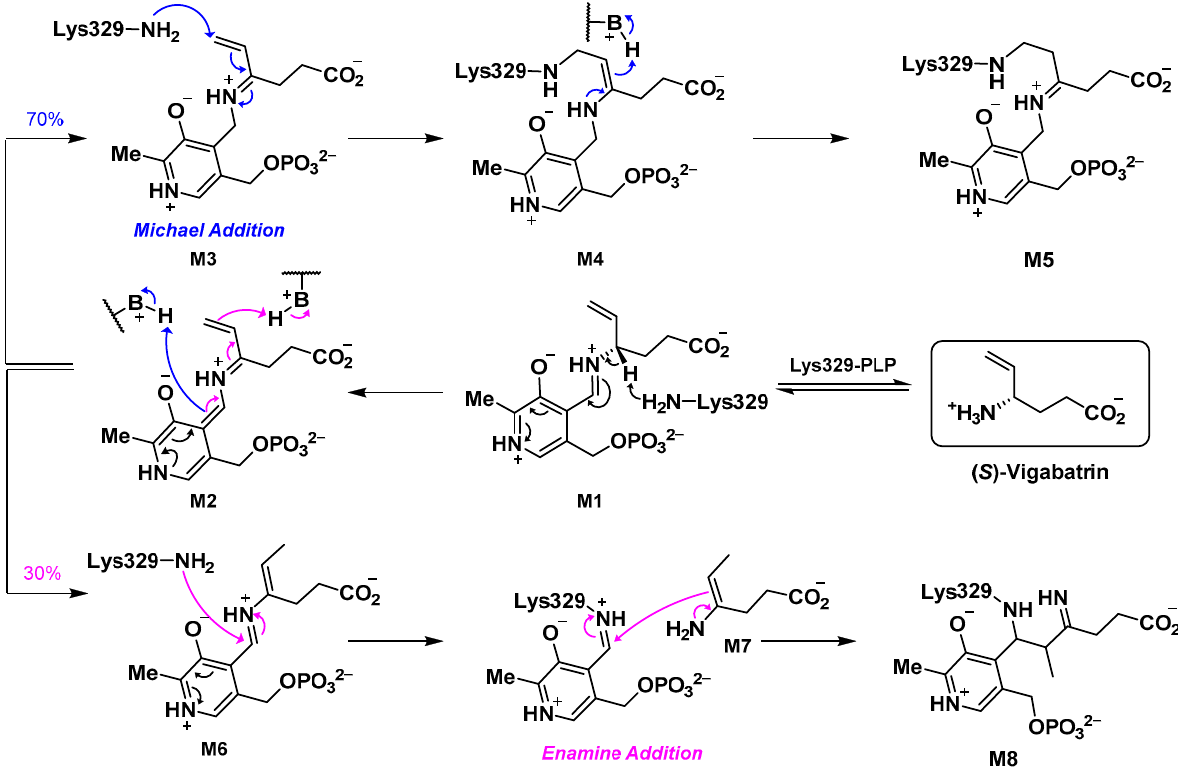
Scheme 1. Mechanisms of inactivation of GABA-AT by ( S